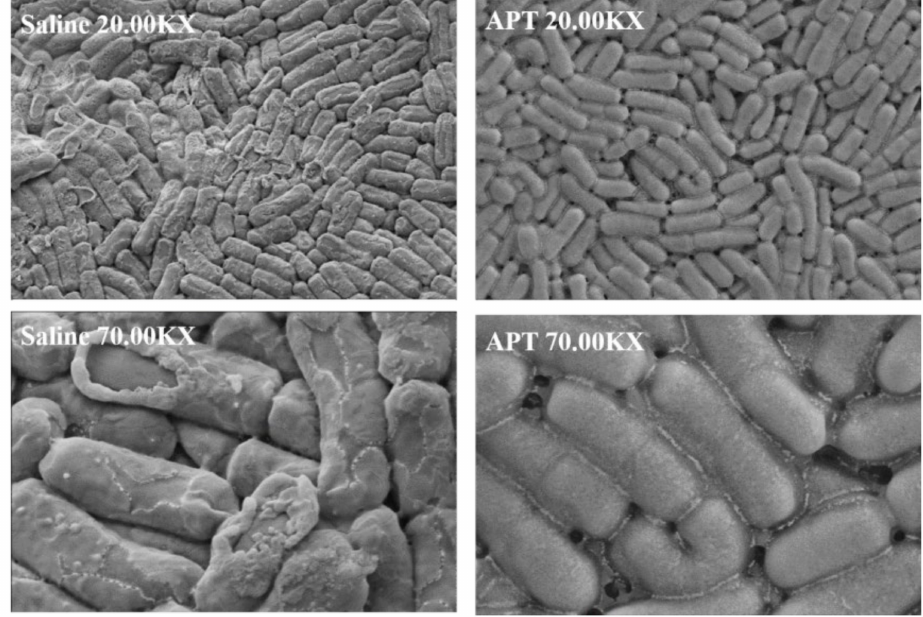
Figure 6. The scanning electron micrographs of L. rhamnosus frozen at − 20 ◦ C for 24 h with saline ( left ) and APT ( right